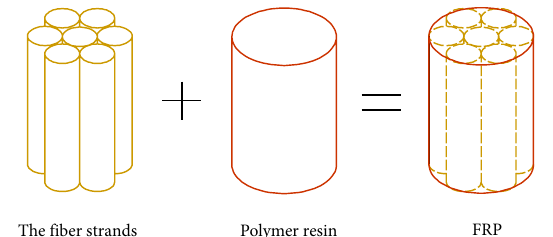
The fiber strands Polymer resin Fig. 3. Structure of the FRP